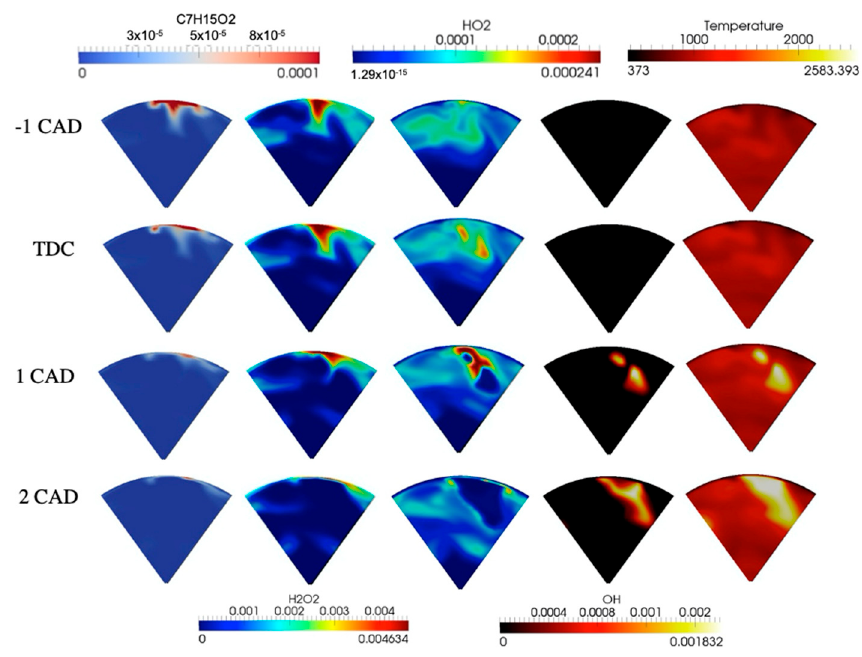
Figure 4. Instantaneous snapshots of mass fractions of (from the left) RO 2 , HO 2 , H 2 O 2 , OH, and temperature during an ignition event for the baseline case 1 between − 1 CAD and 3 CAD in the horizontal plane 8.6 mm below the cylinder head.